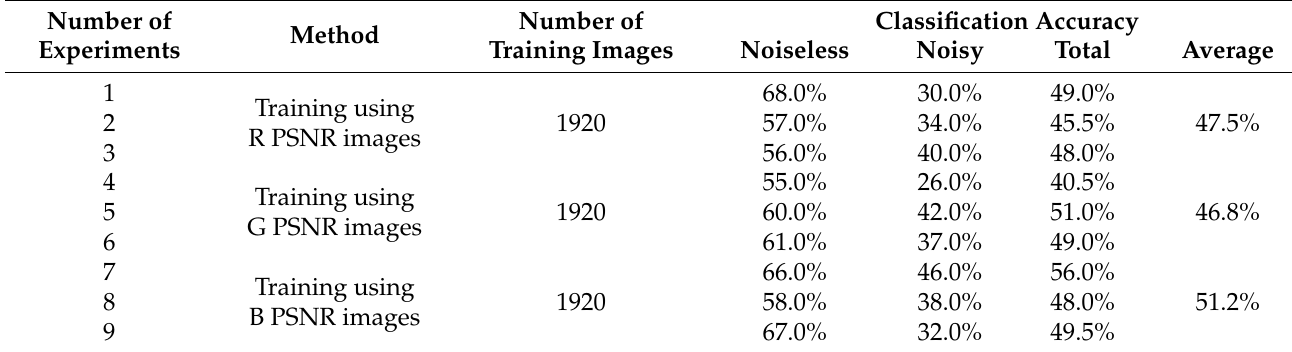
Table 5. Classification accuracy of the network trained using images obtained by applying the inverse PSNR to three channels individually.